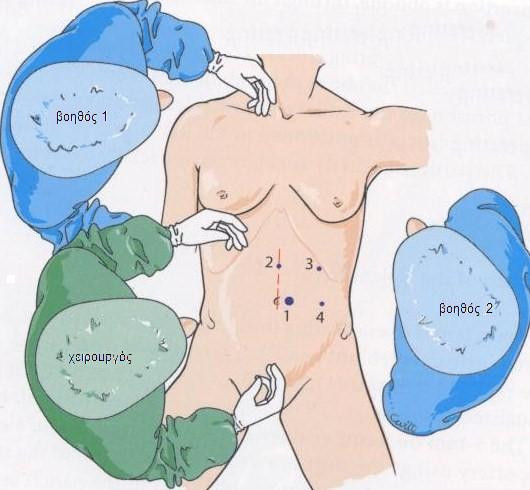
Position of trocars.